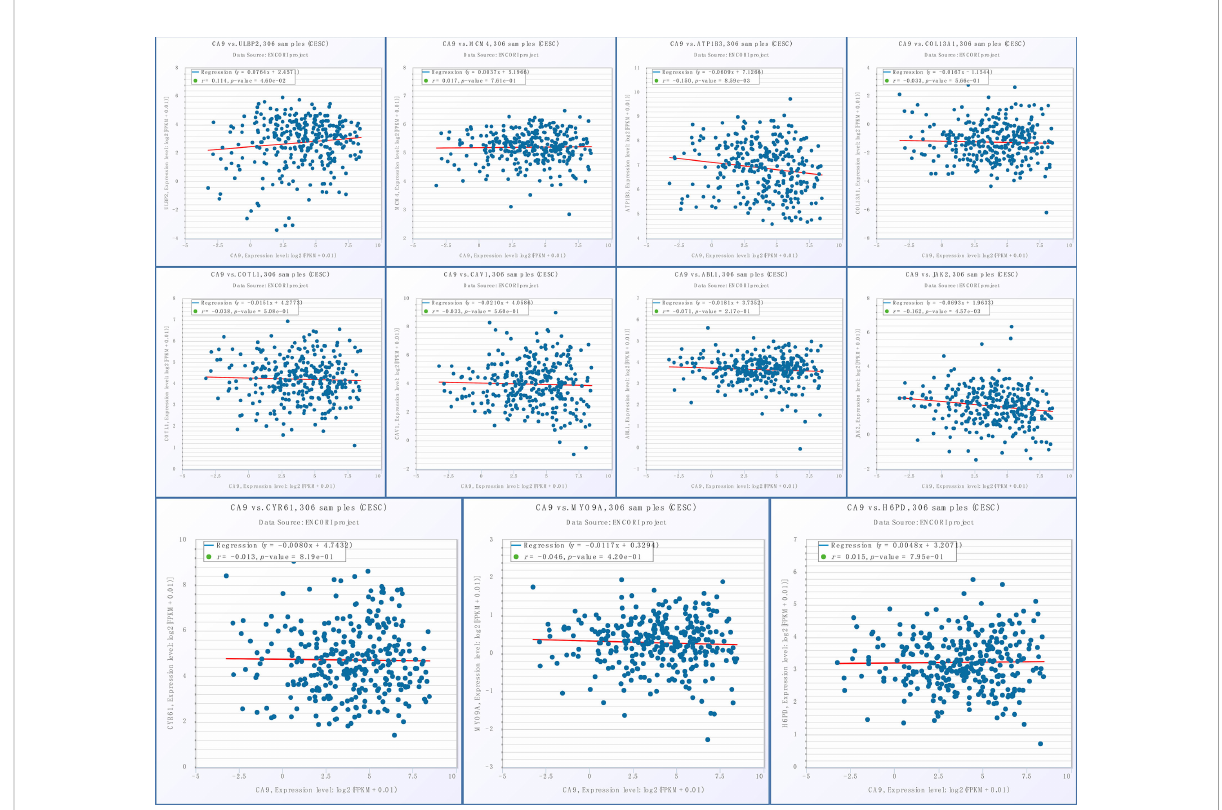
FIGURE 10 Association of CA9 and ceRNAs. From left to right: the 1st row shows the correlation between CA9 and ULBP2, MCM4, ATP1B3, COL13A1; the 2nd row displays the correlation between CA9 and COTL1, CAV1, ABL1, JAK2; the 3rd row shows the correlation between CA9 and CYR61, MYO9A,